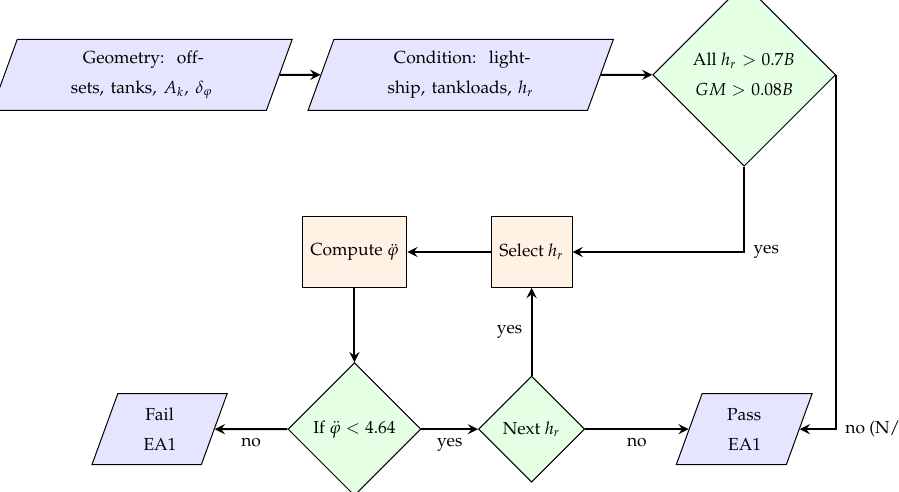
Figure 7. Excessive acceleration Level 1 algorithm process